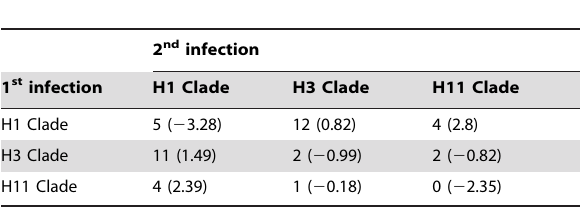
Table 1. Contingency table for HA re-infections with common HA clades. Table 2. Contingency table for HA re-infections with HA